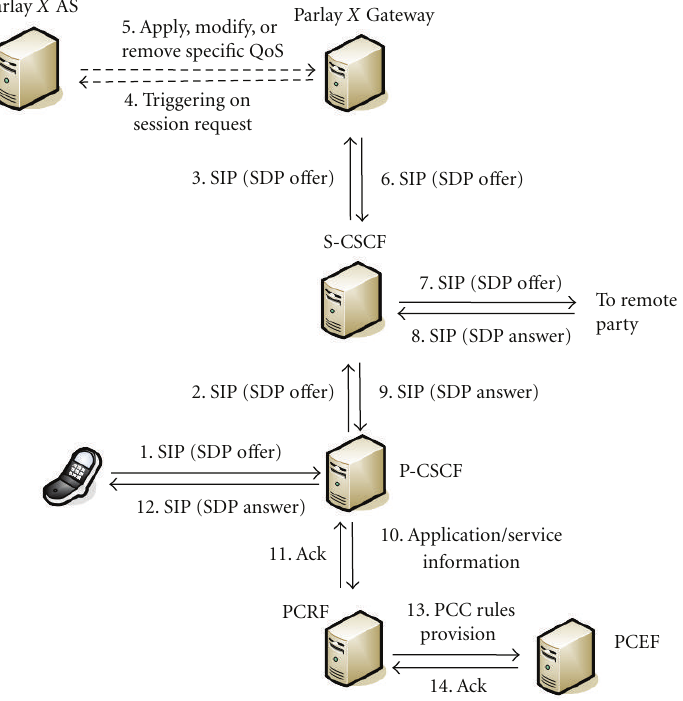
Figure 2: Application control on QoS during session